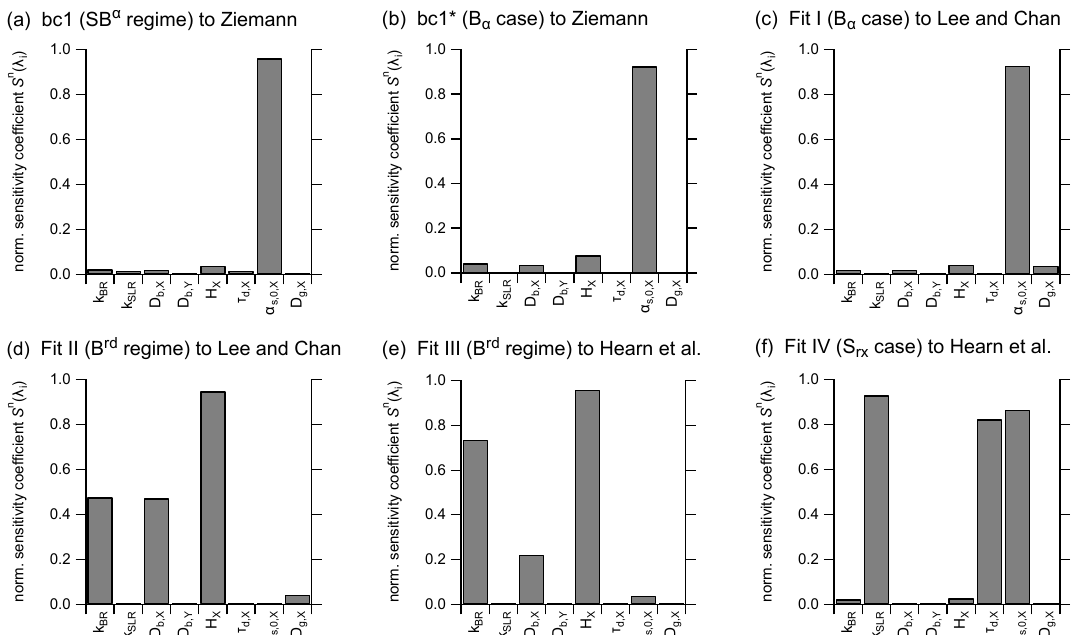
Fig. 7. Sensitivity profiles of parameter sets for a KM-SUB simulation of oleic acid–ozone. The parameter values used to generate these fits are shown in Table 6. Datasets are: (a) and (b) , Ziemann (2005); (c) and (d) , Lee and Chan (2007); (e) and (f) , Hearn et al. (2005). These sensitivity tests corroborate the limiting case and regime assignments made in this study, and indicate that the 9 : 1 criterion is sufficient to separate limiting case behaviours. The sensitivity coefficients were determined via Morris’ Elementary Effects method for global sensitivity analysis (Morris, 1991) as recommended by Saltelli et al.